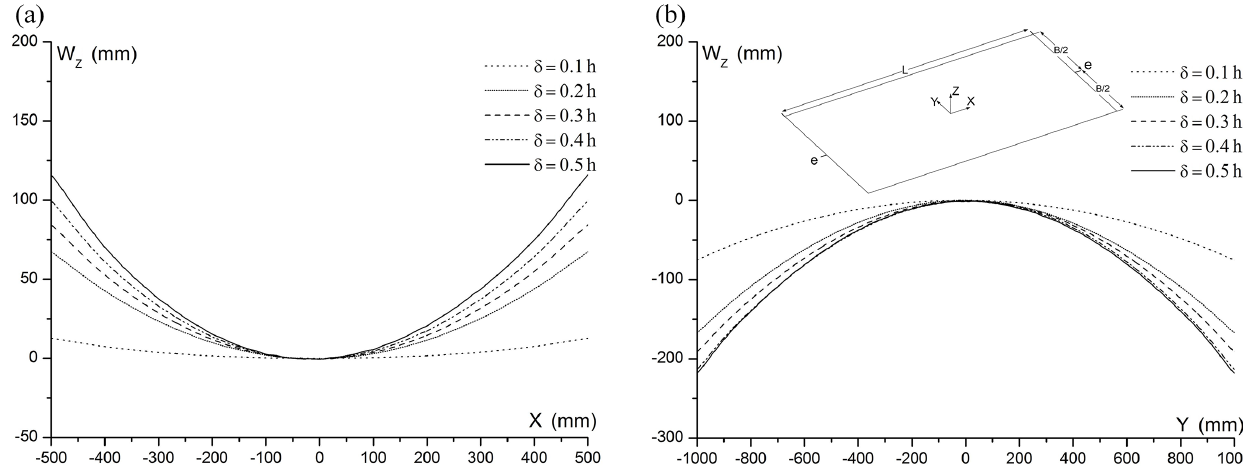
Figure 16. Impacts of roller press amount on saddle plate forming. (a) Results from lateral section. (b) Results from longitudinal